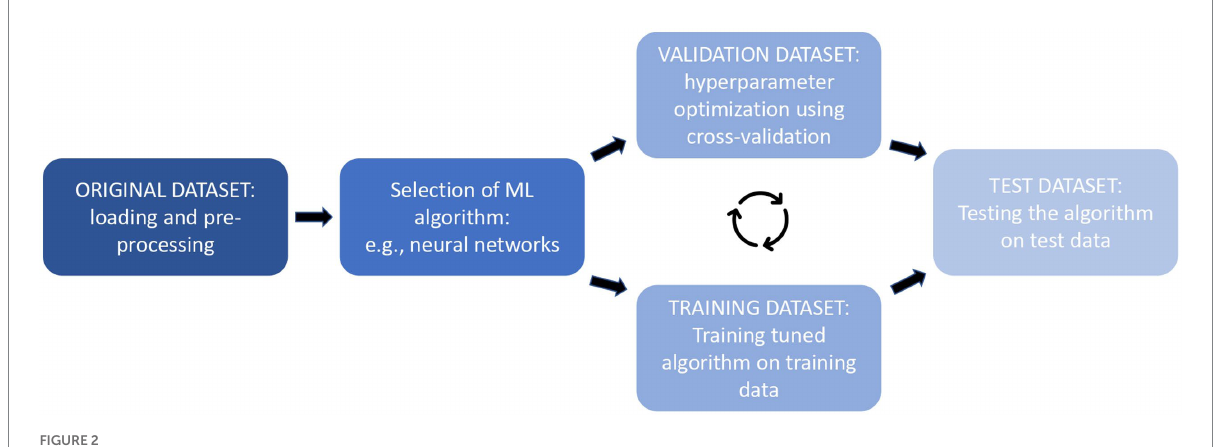
FIGURE 2 Representation of the training, validation, and testing processes in